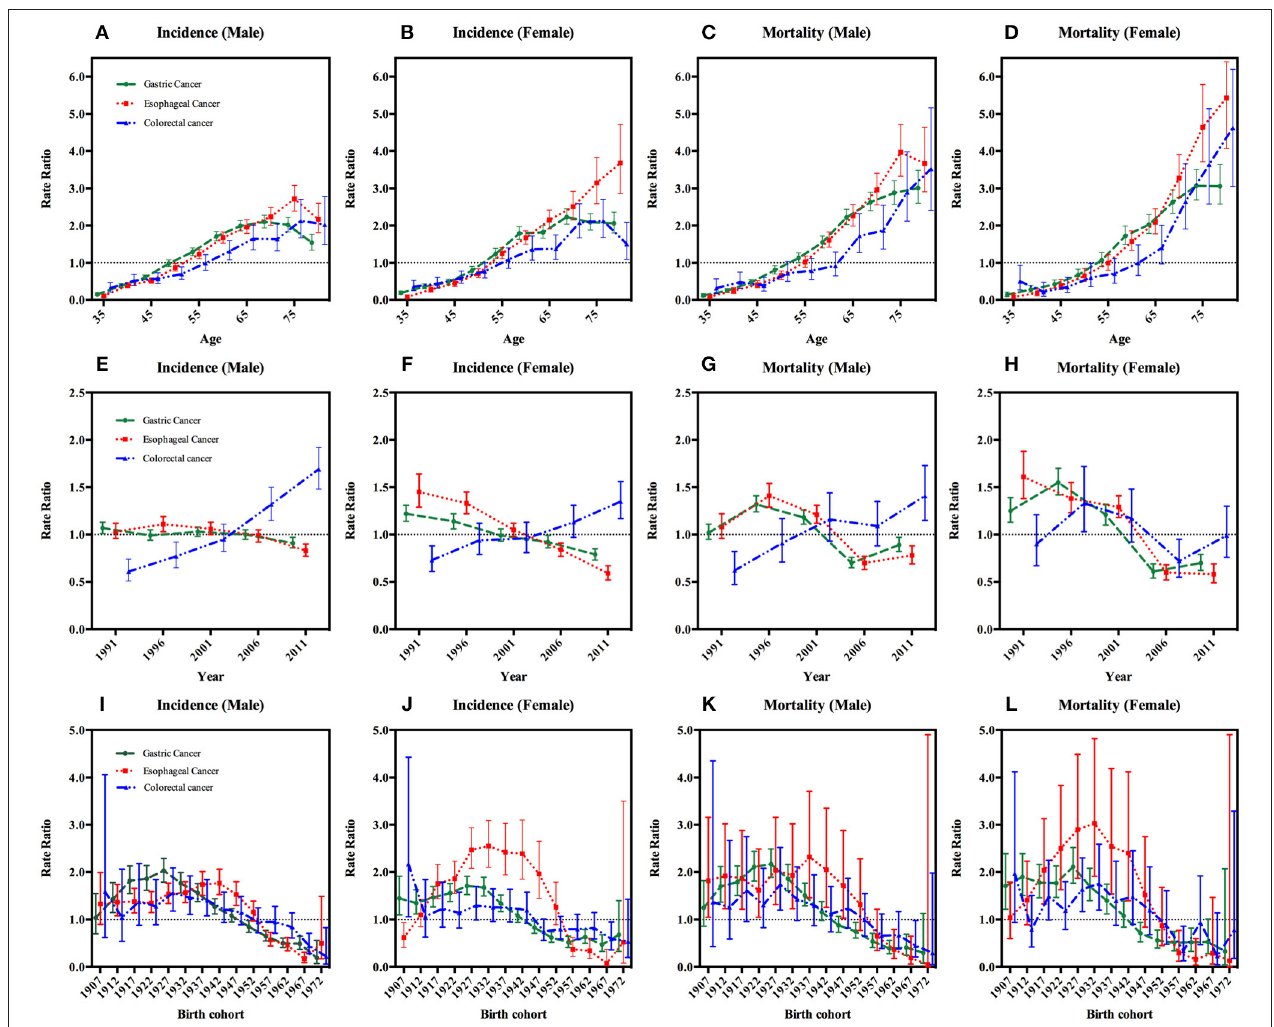
FIGURE 2 | Age, period, and cohort effects on gastrointestinal cancers incidence and mortality with 95% confidence interval, stratified by sex. Footnotes: The age, period and cohort effects are estimated by a log-linear model using the intrinsic estimator (IE) method and expressed as rate ratios. (A–D) In the first row represent age effects after adjusting for period and cohort effects. (E–H) In the second row are the estimated period effects after adjusting for age and cohort effects. In the year 2004, a population-based endoscopy screening program in high-risk areas was initiated. (I–L) In the last row are the cohort effects after adjusting for age and period